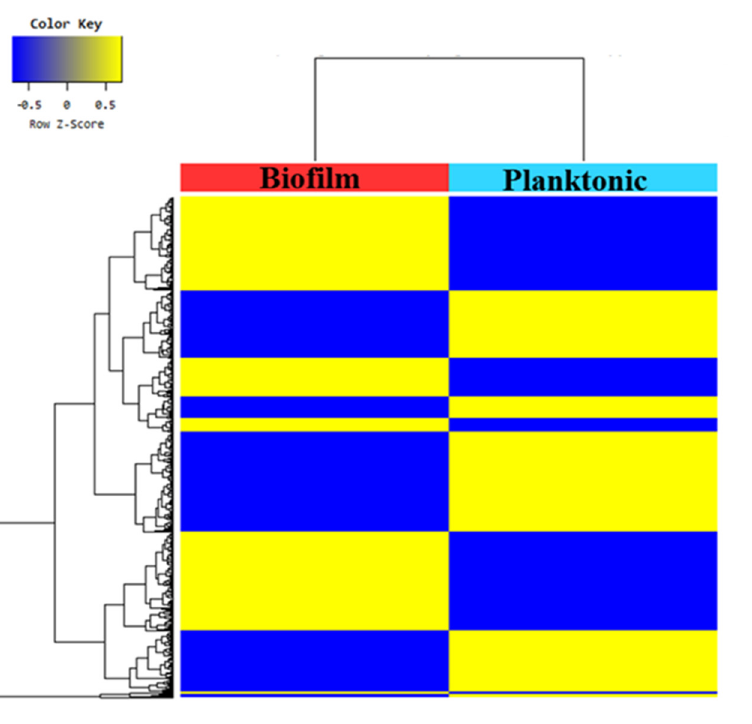
Figure 3. Heat map of the one-way hierarchical clustering using Z-score for normalized value (log2 based).